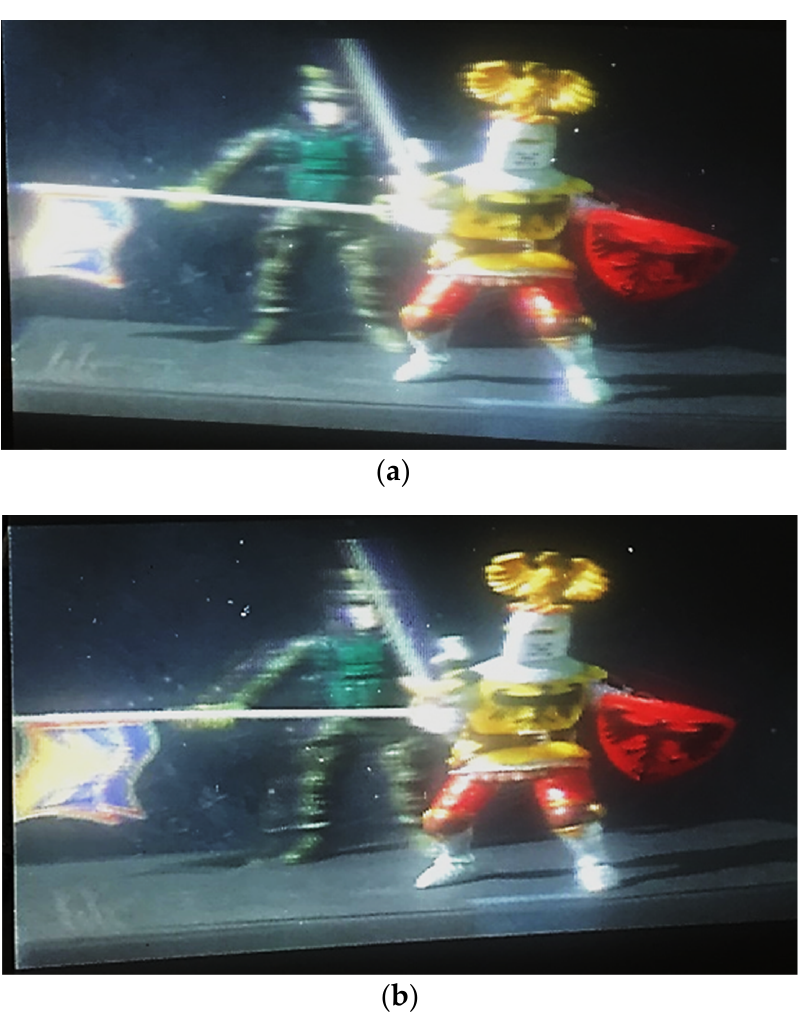
Figure 9. Forty inch 3D images using 4K ultra HD projector. ( a ) View from the left; ( b ) view from the right.